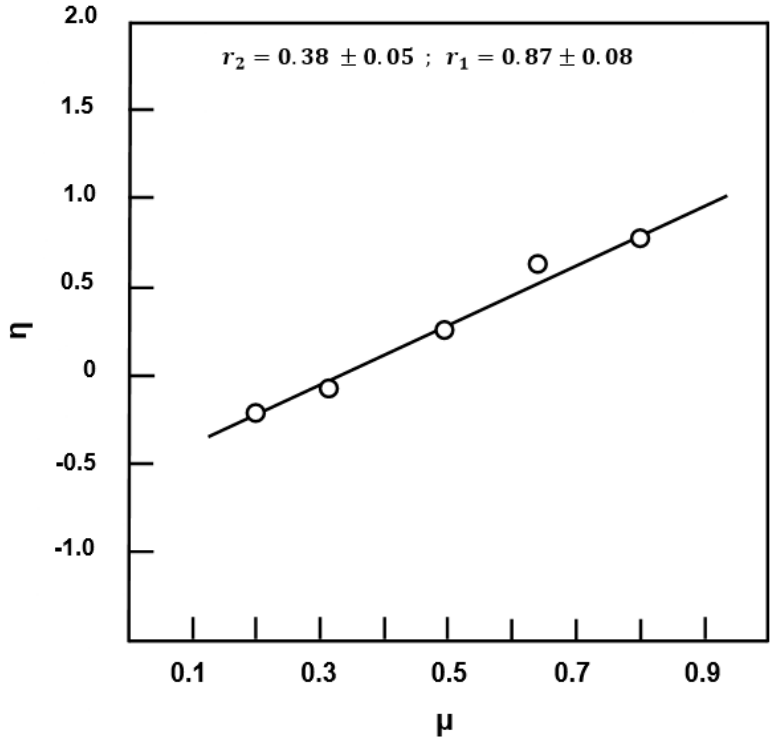
Figure 10. Fineman–Ross plot indicating variation of G vs. H for copolymerization of EUGMA with MMA.